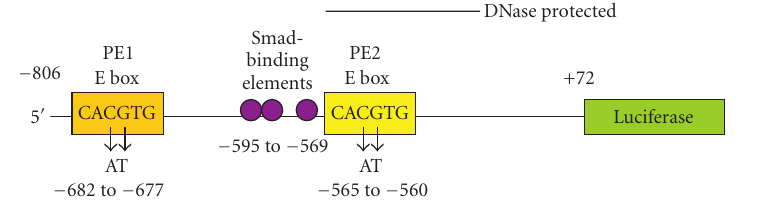
Figure 2: Topography of the PAI-1p806-Luc reporter construct illustrating the two (PE1 and PE2) E box sequences. Site-directed mutagen- esis and luciferase assays clearly indicated that an intact E box at the PE2 site is required for maximal TGF- β 1-induced PAI-1 transcription in human epithelial cells